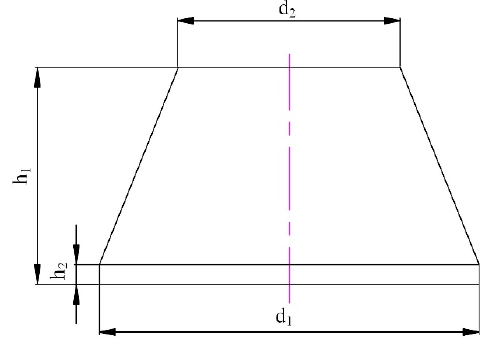
Figure 4. Barnacle geometrical model and dimensions.